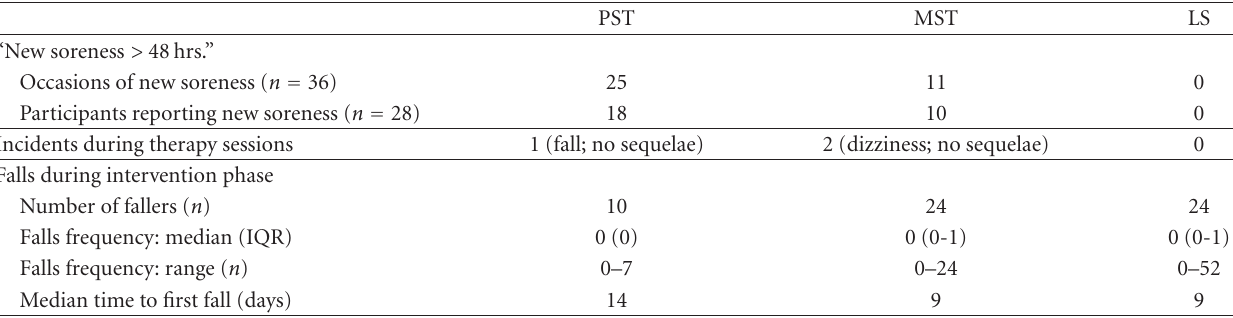
Table 1: Safety during the intervention phase.